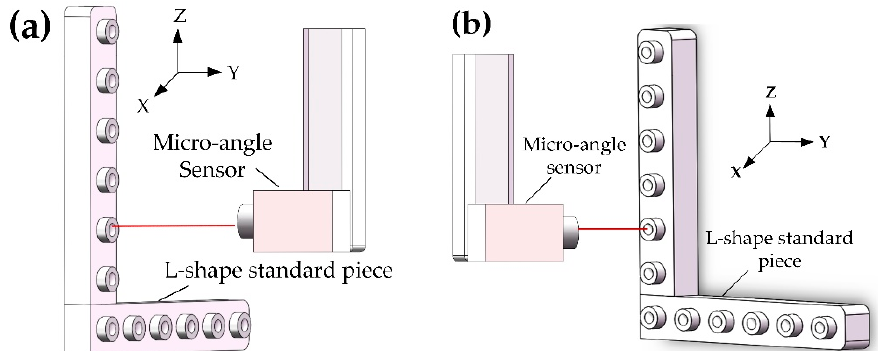
Figure 8. ( a ) Measurement in the XOZ plane; ( b ) Measurement in the YOZ plane.